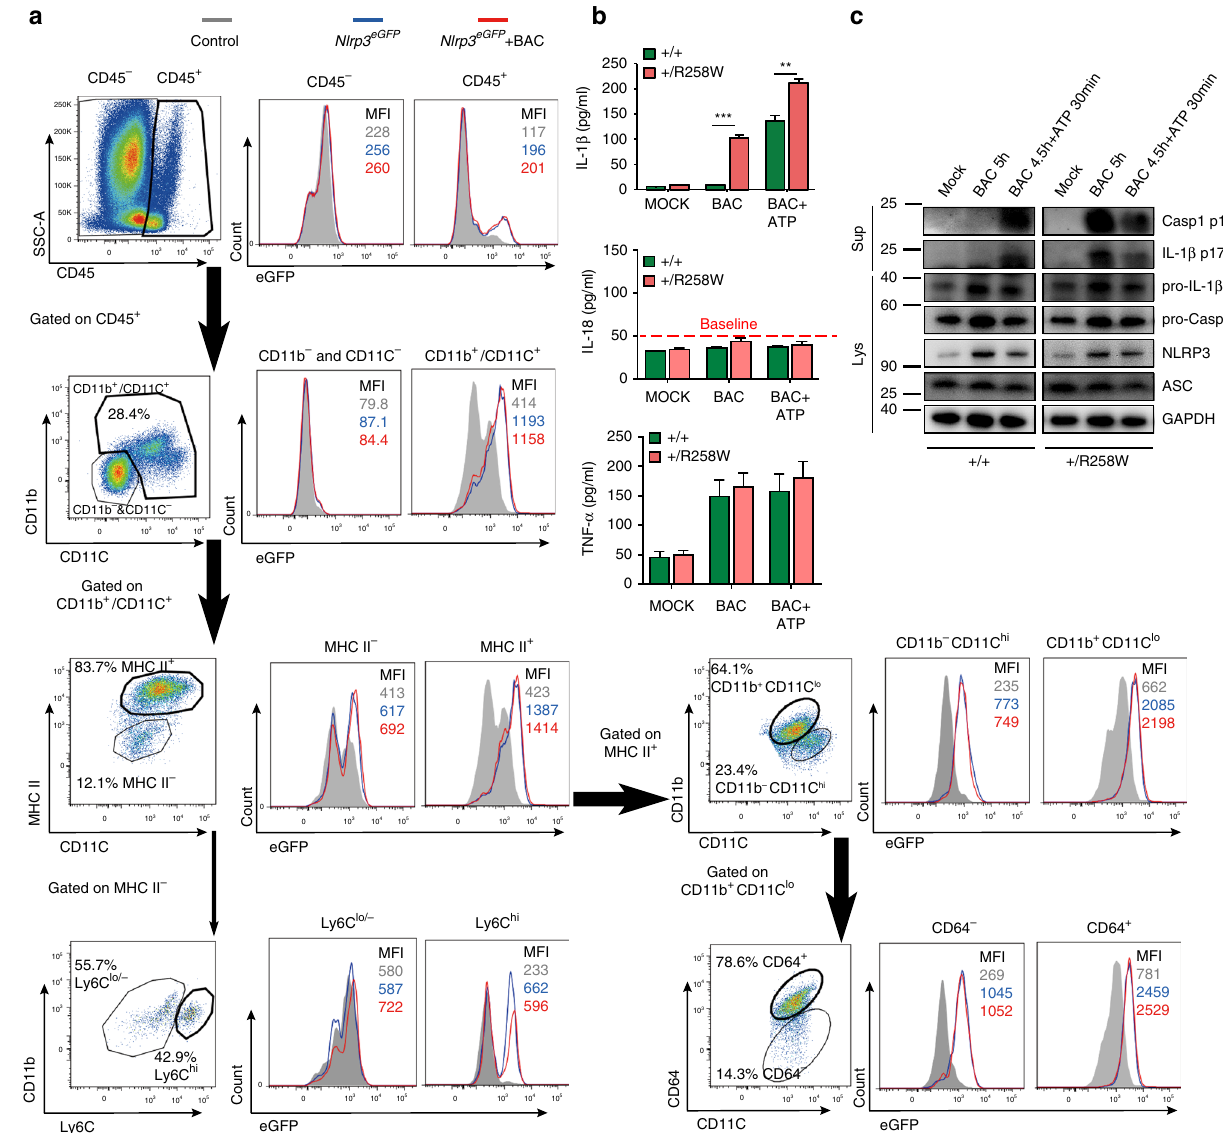
Fig. 1 Intestinal lamina propria CD11b + /CD11C + mononuclear phagocytes from Nlrp3 R258W mice contain hyperactive in fl ammasome. a Colonic lamina propria mononuclear cells (LPMCs) were isolated from control mice (gray fi lled) or Nlrp3 eGFP reporter mice left untreated (blue line), or stimulated with heat-inactivated fecal bacteria (BAC) at multiplicity of infection (MOI) = 20:1 for 4 h (red line); different cell populations were identi fi ed by the indicated surface markers and were examined for NLRP3-eGFP expression. MFI represents geomean fl uorescence intensity of eGFP in each sample. b , c Colonic LPMCs were stimulated with BAC (MOI = 20:1) for 12 h ( b ) or 5 h ( c ) with or without a ATP pulse for 30 min; control cells (MOCK) were not stimulated. IL-1 β , IL-18, and TNF- α in the supernatants were determined through ELISA. The data are representative of at least three independent experiments and are shown as the means ± SEM. ** P < 0.01, *** P < 0.001 (Two-tailed Student ’ s t test) ( b ); cleaved caspase-1 p10 subunit, IL-1 β -p17 fragment in the supernatants (Sup), and their pro-forms together with NLRP3, ASC, and GAPDH in the cell lysates (Lys) were detected by western blot ( c